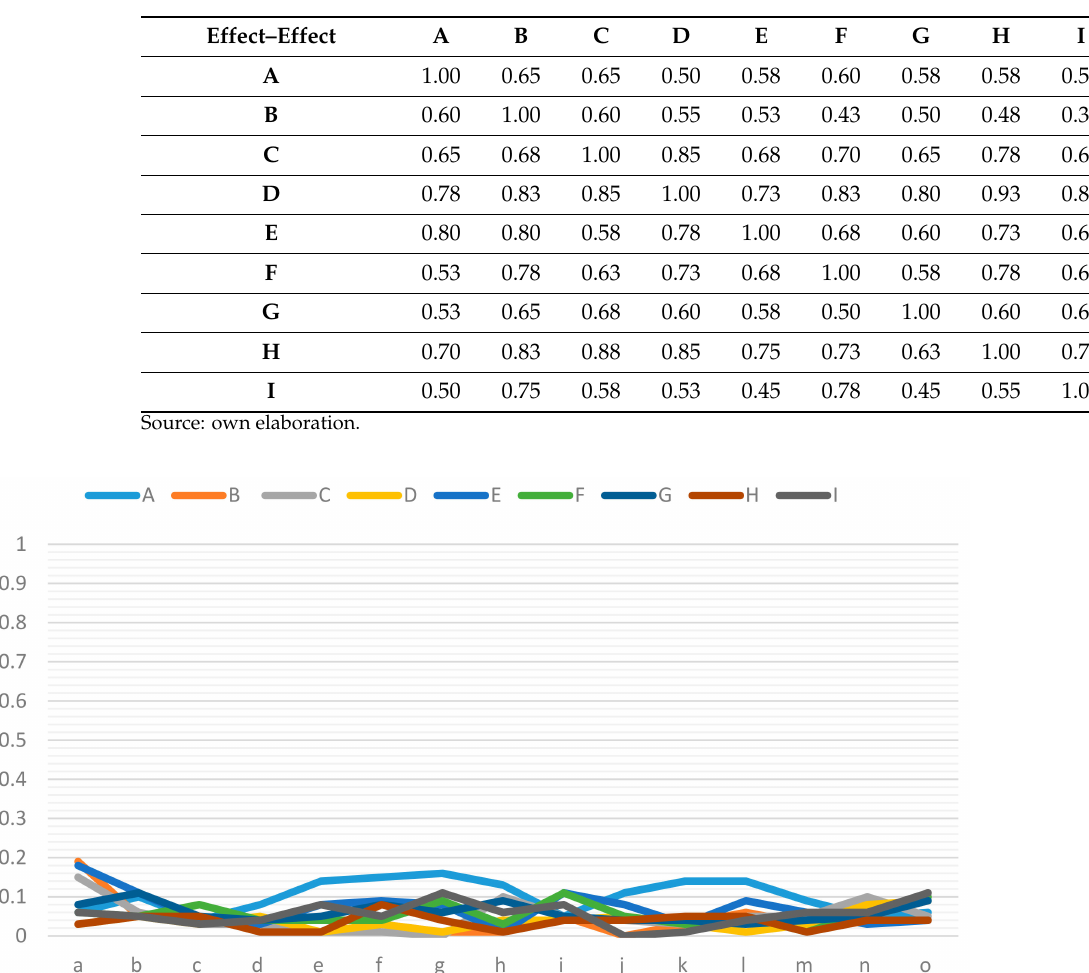
Table 9. Expertons made up of the effect–effect assessment carried out by the group of academic experts/researchers (Matrix B2).